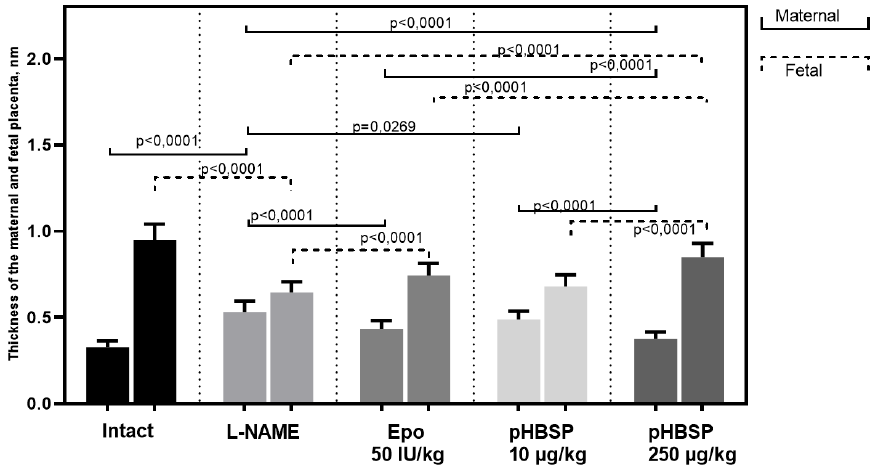
Figure 11. The effect of pHBSP on the thickness of the maternal and fetal placenta in animals with experimental preeclampsia ( n = 10 animals in each group).